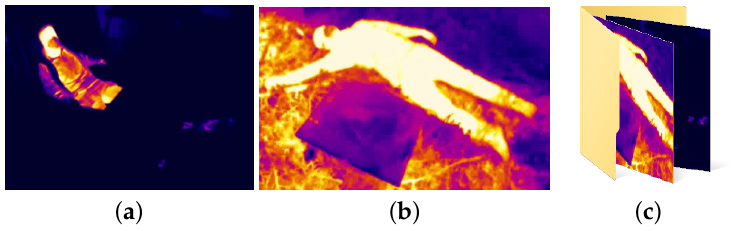
Figure 6. Different datasets used in training. ( a ) Night dataset. ( b ) Day dataset. ( c ) Combined dataset. Source: Authors